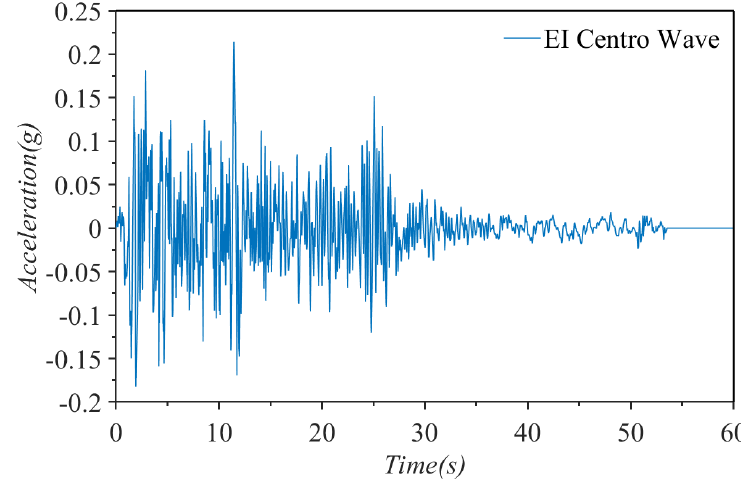
( b ) Figure 8. Responses of the SDOF systems with an ECD or FVD subjected to half-cycle sine shock at the same maximum displacement and damper force: ( a ) Displacement time history; and ( b ) Force- velocity relationships of the ECD and the FVD within the time history. Moreover, the shock vibration control performance of the ECD and the FVD under seismic excitation is also considered in this study. Figure 9 shows the acceleration time histories of the EW El Centro wave, and Figure 10 shows the displacement time histories of the SDOF system in three conditions, i.e., without damper, with an FVD, and with an ECD. In this case, the damper constant and the damper exponent of the FVD are 12 kN·s/m and 0.7, respectively. The parameters of the ECD are determined by the design method in [38], with 𝑣 (cid:3030)(cid:3045) = 0.786𝑣 (cid:3040)(cid:3028)(cid:3051) = 0.29 m/s and 𝐹 (cid:3040)(cid:3028)(cid:3051) = 𝑐 (cid:3028) |𝑣 (cid:3040)(cid:3028)(cid:3051) | (cid:3080) , where 𝑣 (cid:3040)(cid:3028)(cid:3051) is the maxi- mum velocity of this SDOF system with a FVD under seismic excitation. Considering that the power spectral densities of the ground motions are larger between 1–2 Hz, the natural